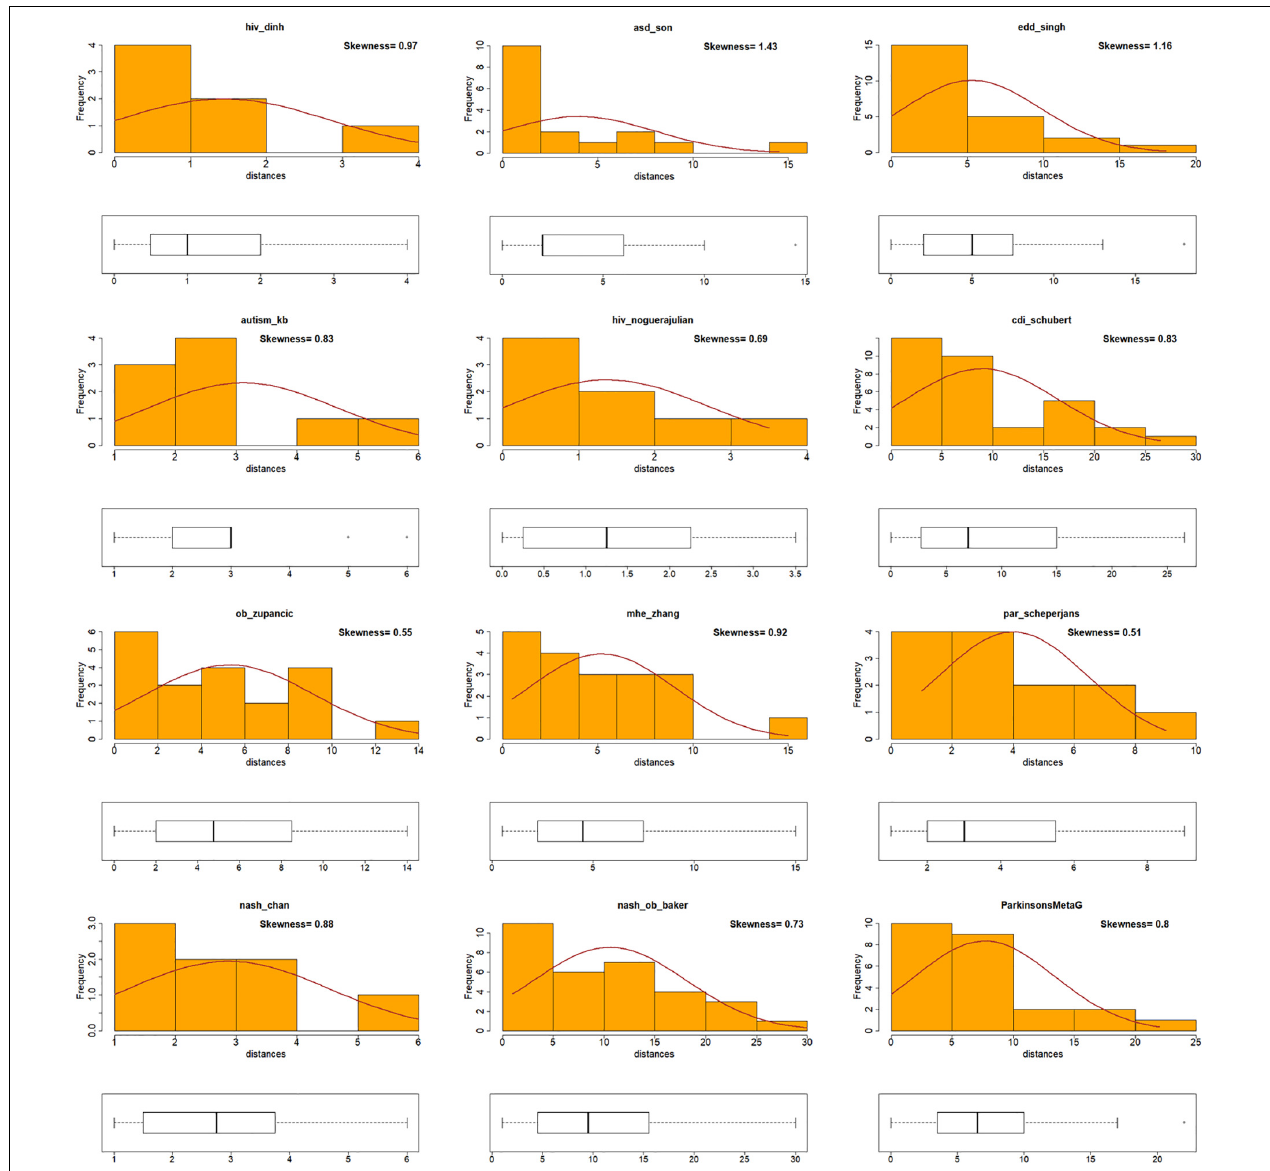
FIGURE 4 | Visualization of skewness for Die score differences for BW and MB networks. Histogram plots for all the data (disease and control) in twelve microbiomes [including Zhu et al. (2013) dataset – labeled as nash_ob_baker], showing the distribution and skewness of the distances ( Dist ). Positively skewed distributions of Dist measures were observed for all twelve